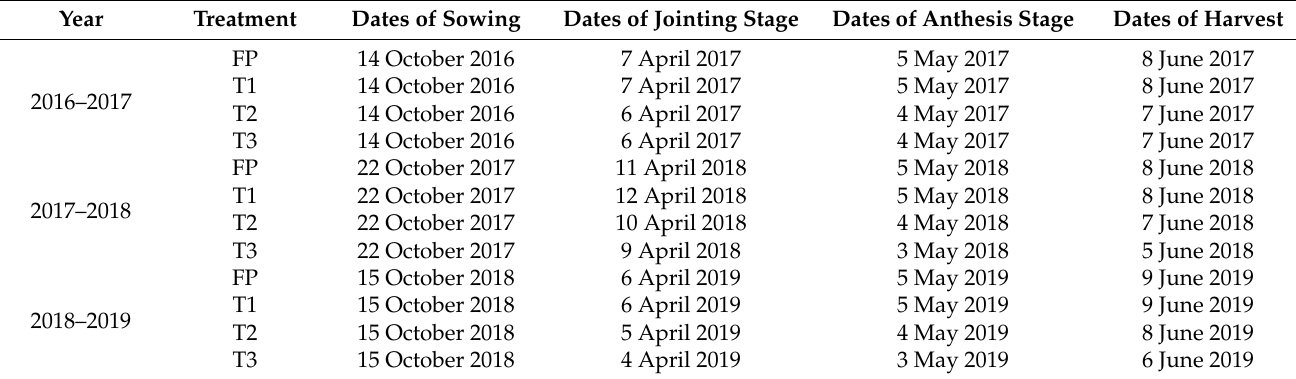
Table 2. Dates of sowing, jointing stage, anthesis, and harvest under different treatments in the 2016–2019 growing seasons of winter